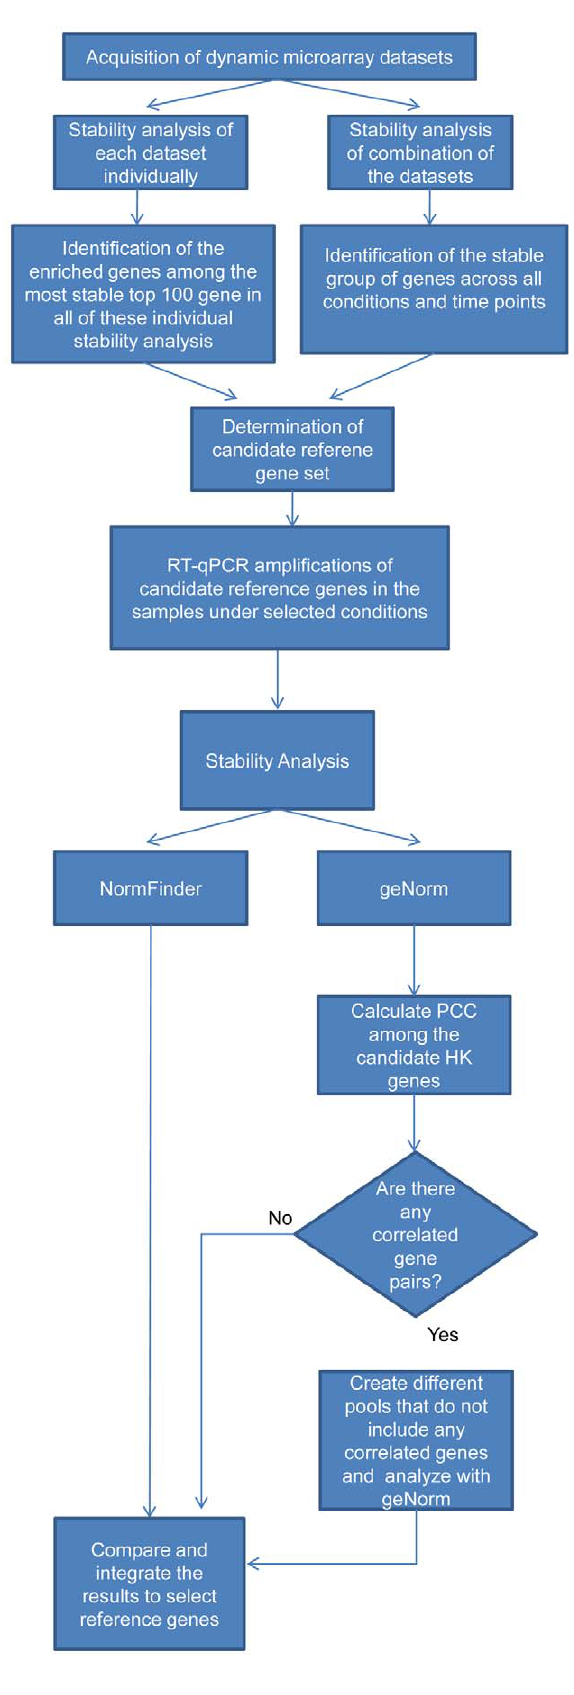
Figure 5. Flowchart representing the approach. This figure represents the general strategy followed for the identification of a pool of reference gene candidates and the determination of a reference gene set to be used for a specific condition in real-time RT-qPCR